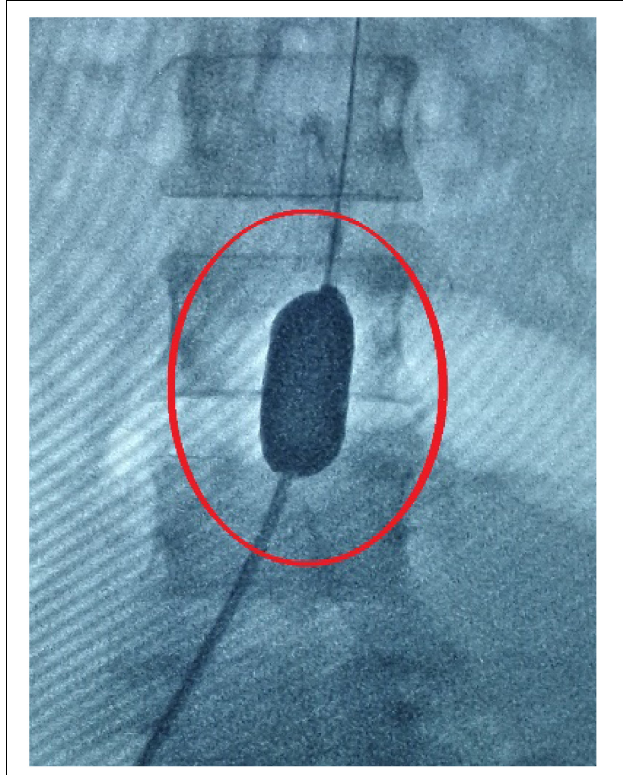
FIGURE 1 | Filled intra-arterial balloon.